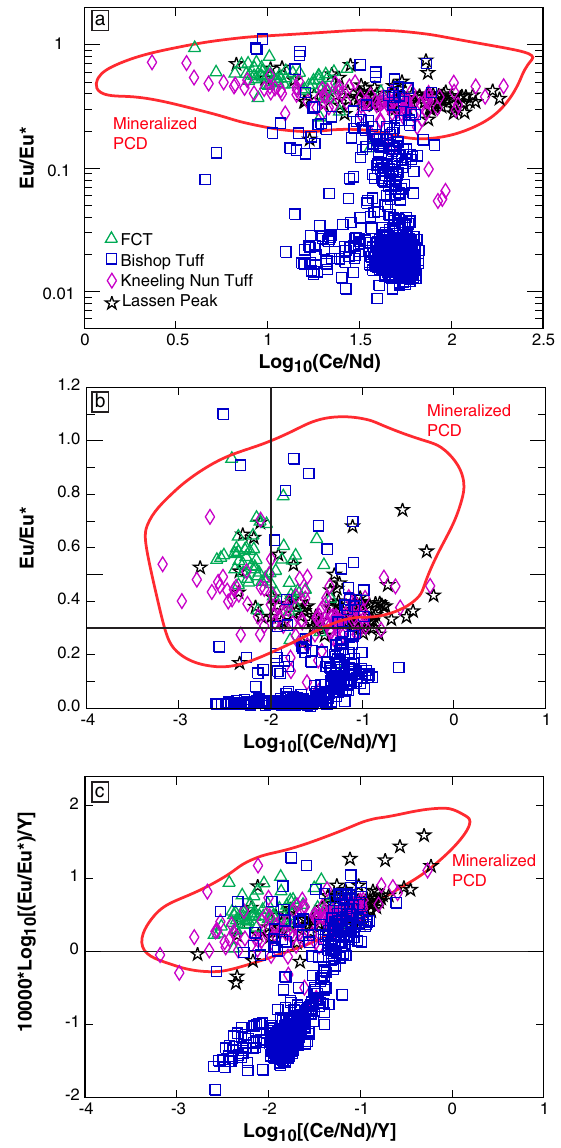
Fig. 7 Trace element plots of zircons from eruptive centers and porphyry copper deposits. Trace element plots of zircons ( a Eu/Eu*-Log 10 (Ce/Nd); b Eu/Eu*-Log 10 [(Ce/Nd)/Y]; c 10000*Log 10 [(Eu/Eu*)/Y]-Log 10 (Ce/Nd)) from eruptive centers of different geodynamic settings (rift: Bishop Tuff; subduction-related: Lassen Peak, Fish Canyon Tuff, FCT, Kneeling Nun Tuff) compared to the fi eld of zircons associated with porphyry copper deposits and the high-sul fi dation epithermal deposit of Yanacocha. The division lines within the plots are from 66 . The porphyry copper deposit fi eld includes zircons from mineralized porphyry intrusions at Butte, Chuquicamata, Escondida, Esperanza, El Salvador, El Teniente, Mirador, Oyu Tolgoi, Yanacocha, and Yerington. Data used in the plot are reported in the Supplementary Data